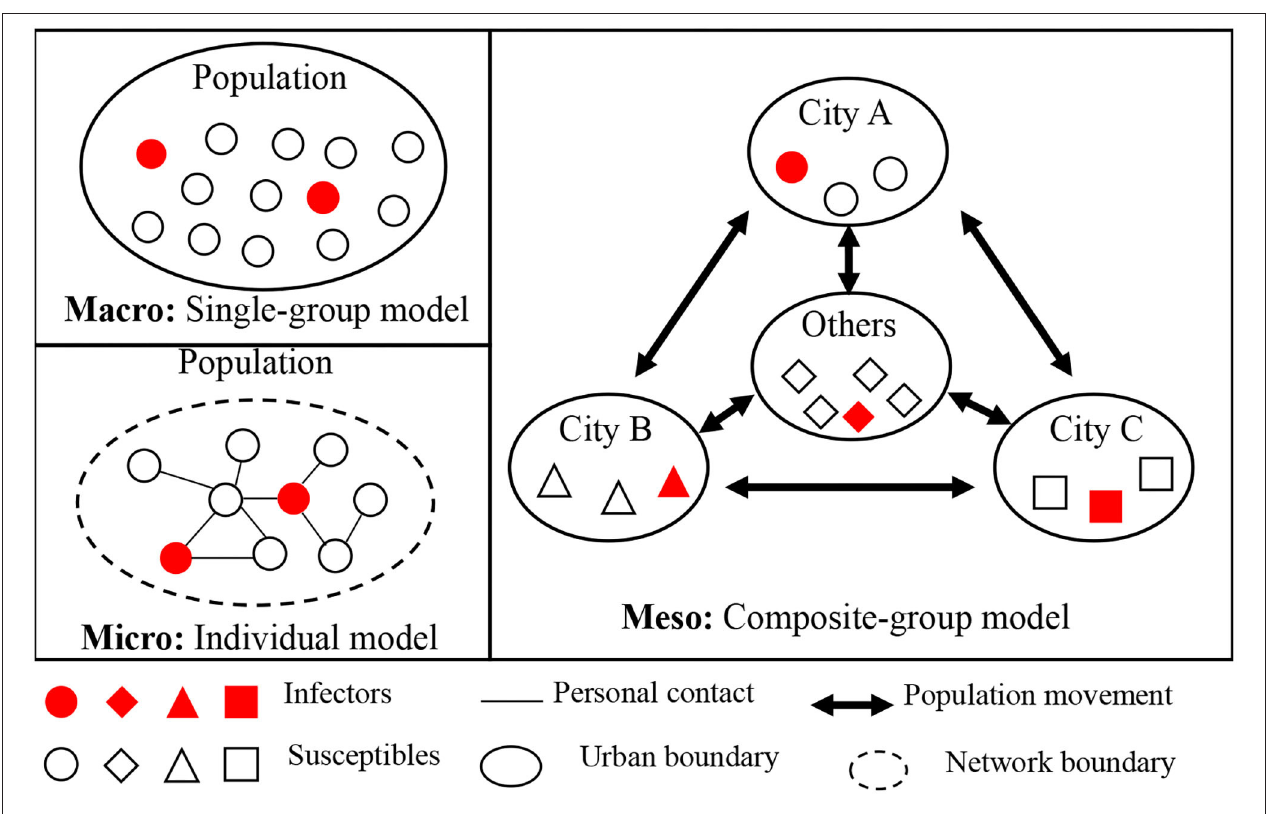
FIGURE 1 | Conceptual framework of regional epidemic transmission